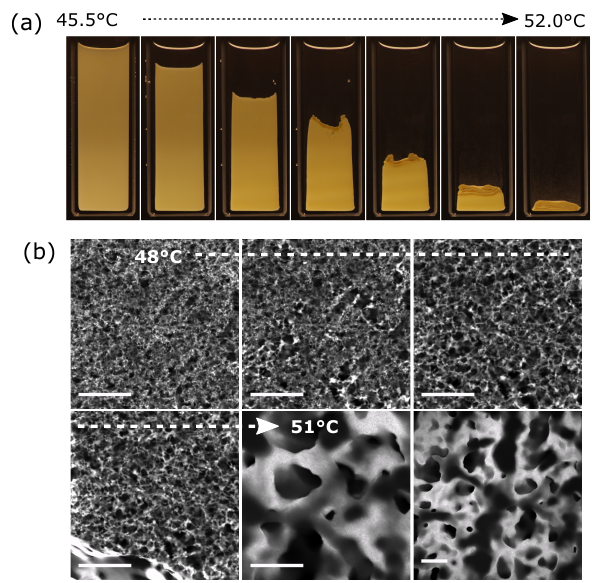
Figure 4. ( a ) A sample (2 vol. % rods) quenched to 45.5 ◦ C, Φ v ≈ 80%, was then slowly heated to 52 ◦ C, Φ v ≈ 30%; ( b ) A time series of confocal micrographs showing (panel 1) the structure of a similar sample at 48 ◦ C, which is subsequently heated (panels 2–5) to 51 ◦ C. The bottom right panel is a